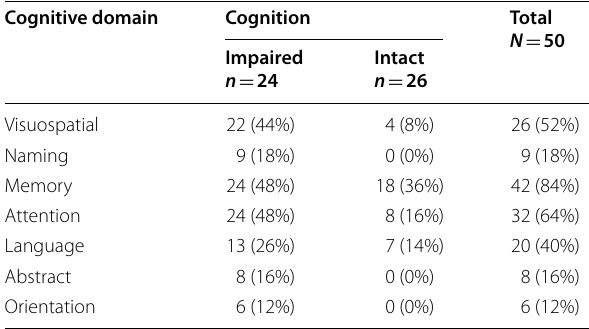
Table 5 Frequency of affected subdomains in patients with multiple sclerosis